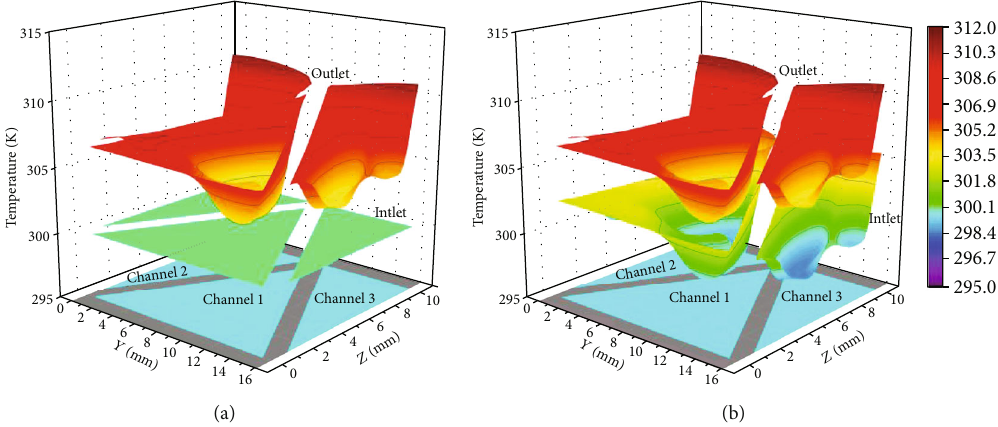
Figure 7: Temperature pro fi les of the inlet and outlet in (a) the fi rst heat transfer simulation and (b) the fi fth iteration. Table 2: Comparison of fl ow and heat transfer characteristics.